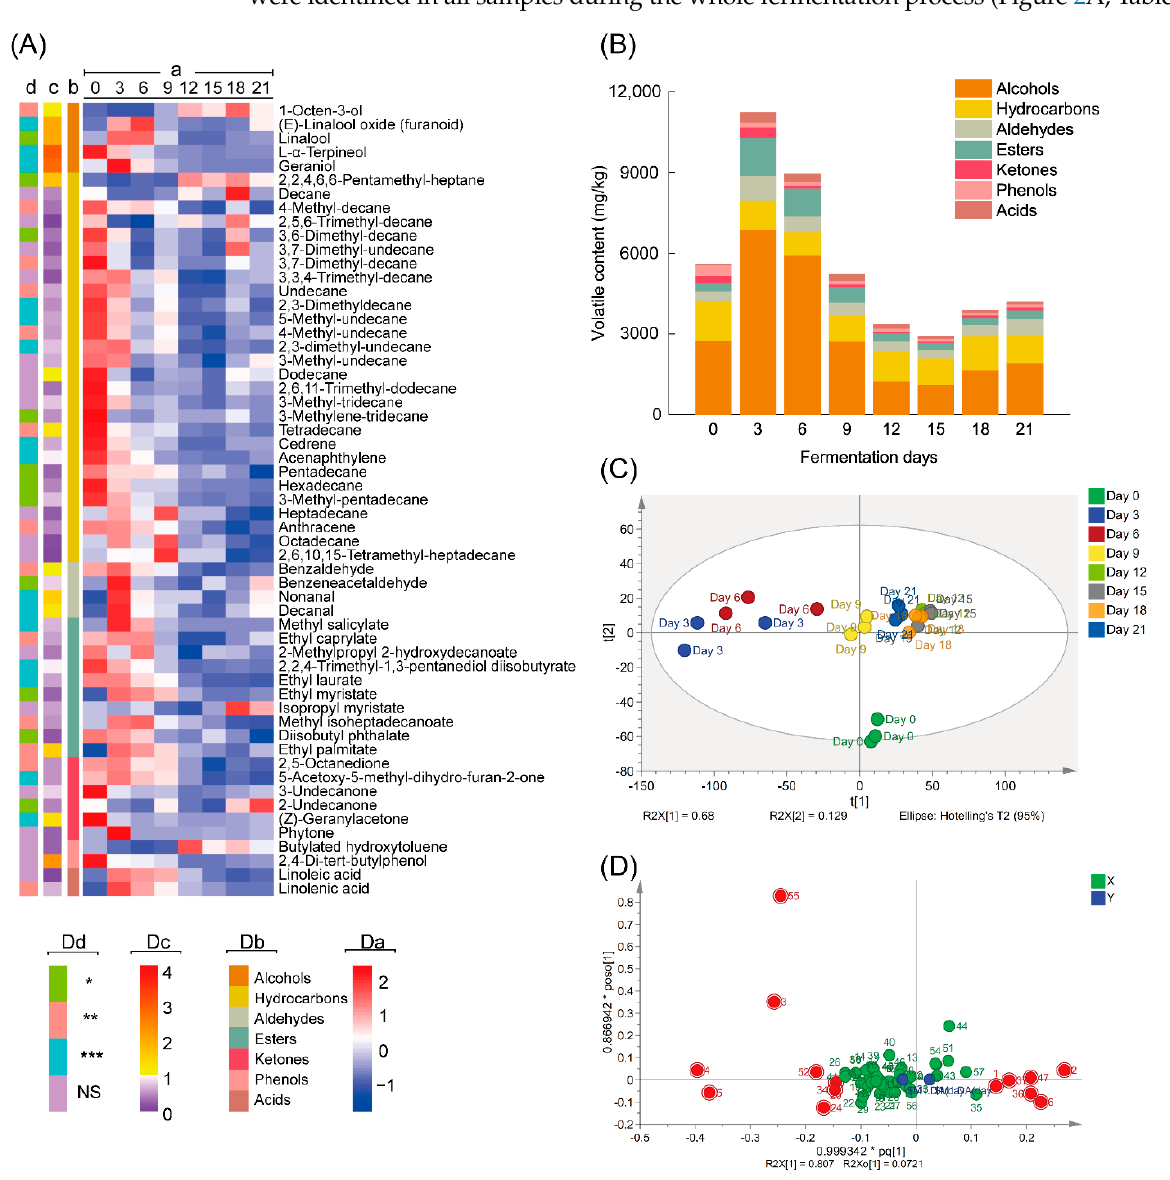
Figure 2. Information of the volatile compounds for the tea samples fermented by Aspergillus niger PW-2. ( A ) Heatmap representing the semiquantitative results (a), chemical classes (b), VIP values (c) and p values (d) of all volatile compounds (NS, p > 0.05; *, 0.01 < p < 0.05; **, 0.001 < p < 0.01; ***, p < 0.001). ( B ) Volatile contents of different classes in samples during fermentation. ( C ) Score scatter plot of PLS-DA analysis based on volatile compounds of all samples. ( D ) Loading scatter plot of OPLS-DA analysis based on volatile compounds of samples on Day 0 and Day